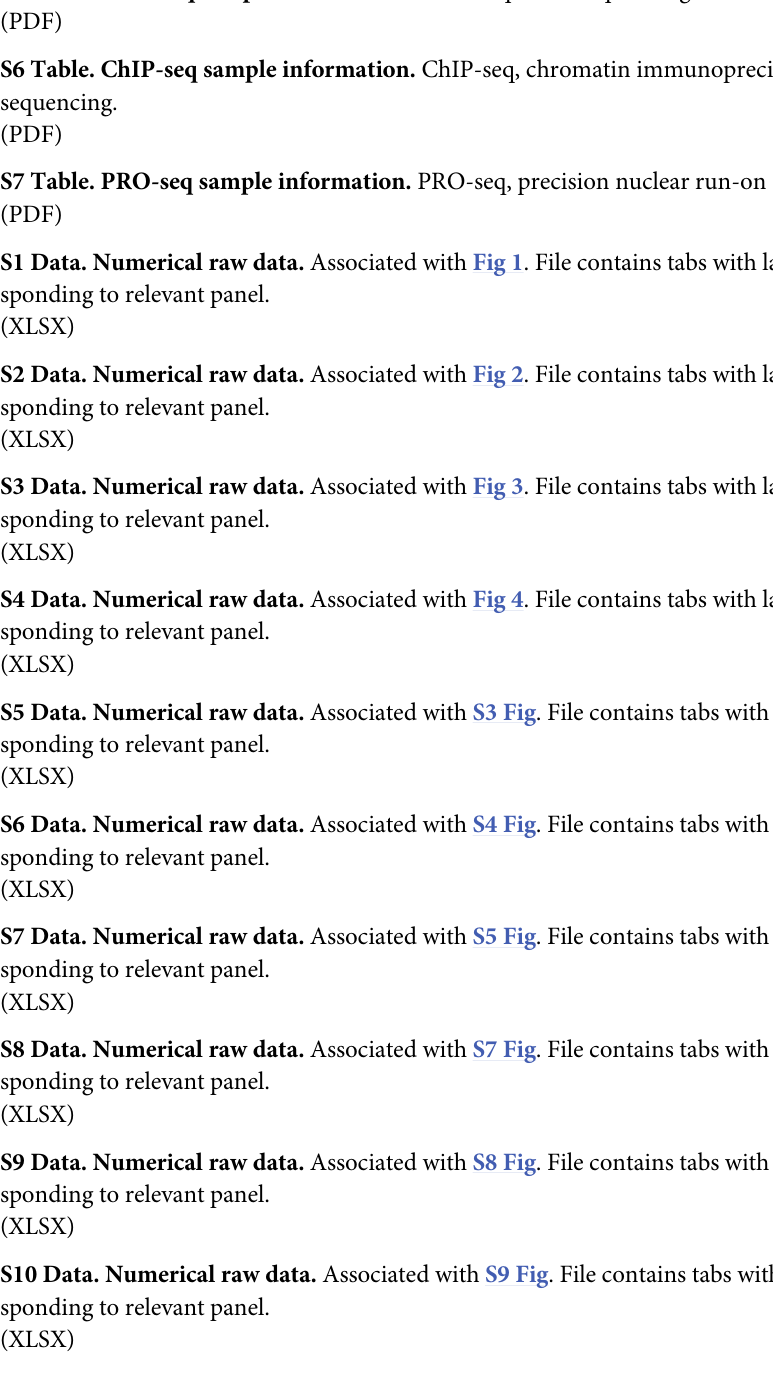
S3 Table. Primer sequences for PCR. (PDF) S4 Table. Metabolomics data. (PDF) S5 Table. RNA-seq sample information. RNA-seq, RNA sequencing. (PDF) S6 Table. ChIP-seq sample information. ChIP-seq, chromatin immunoprecipitation sequencing. S7 Table. PRO-seq sample information. PRO-seq, precision nuclear run-on